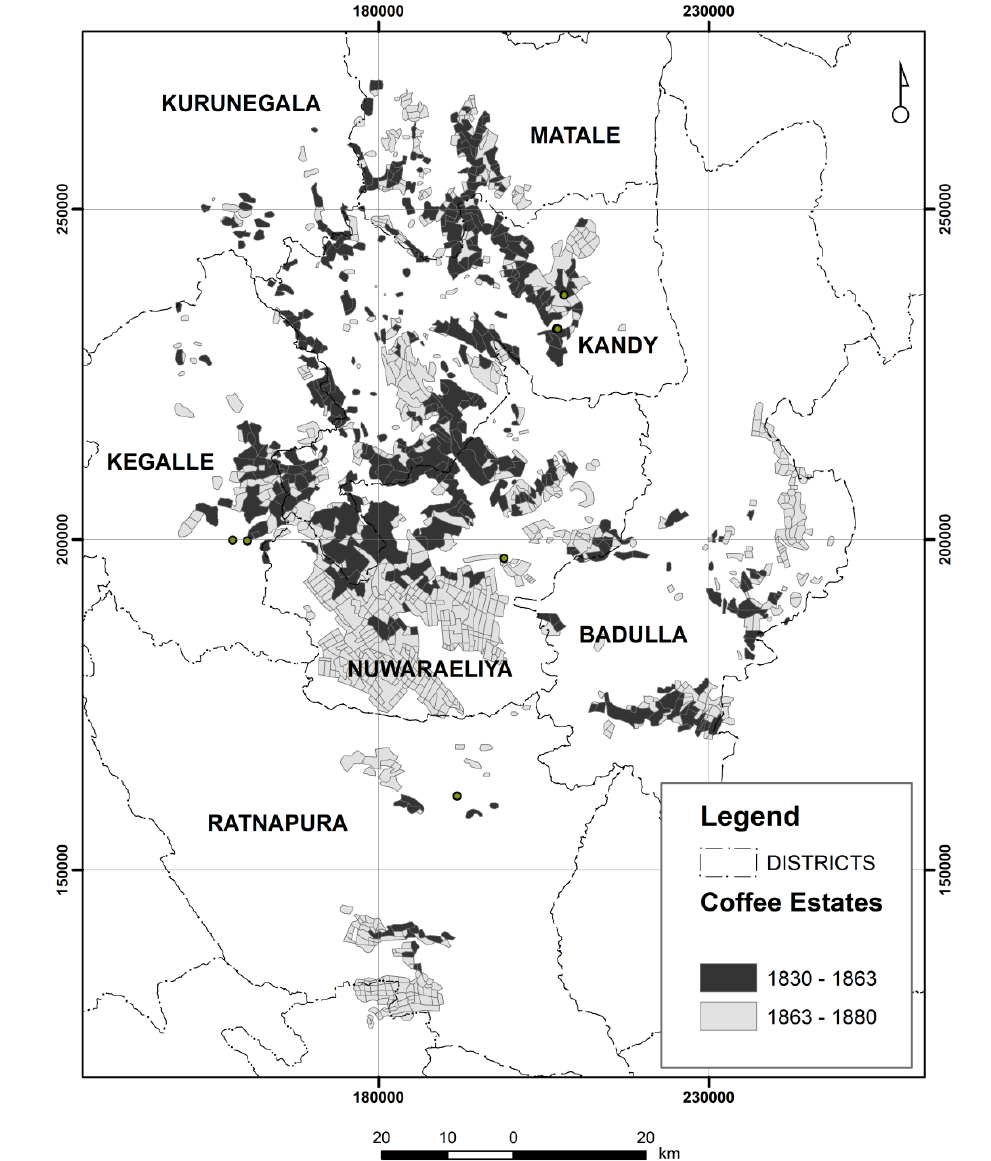
Figure 6: Spread of coffee estates in the central highlands from 1830 to